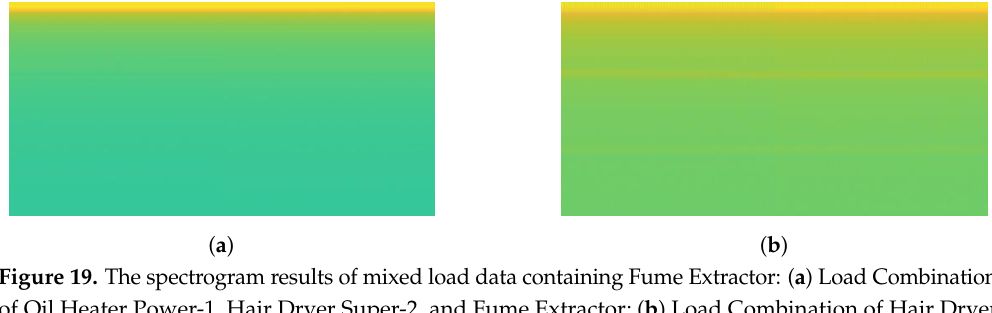
Figure 19. The spectrogram results of mixed load data containing Fume Extractor: ( a ) Load Combination of Oil Heater Power-1, Hair Dryer Super-2, and Fume Extractor; ( b ) Load Combination of Hair Dryer Super-1 and Fume Extractor.